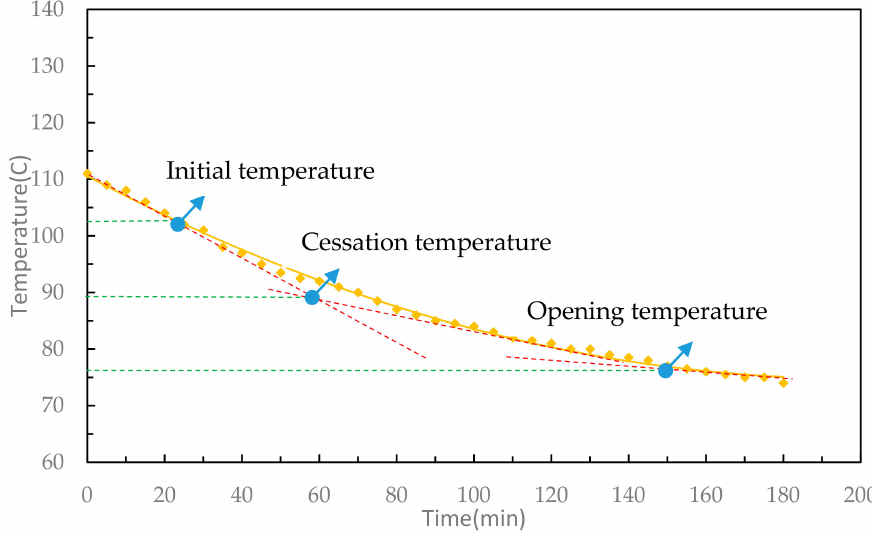
Figure 4. Cooling interval diagram of the asphalt